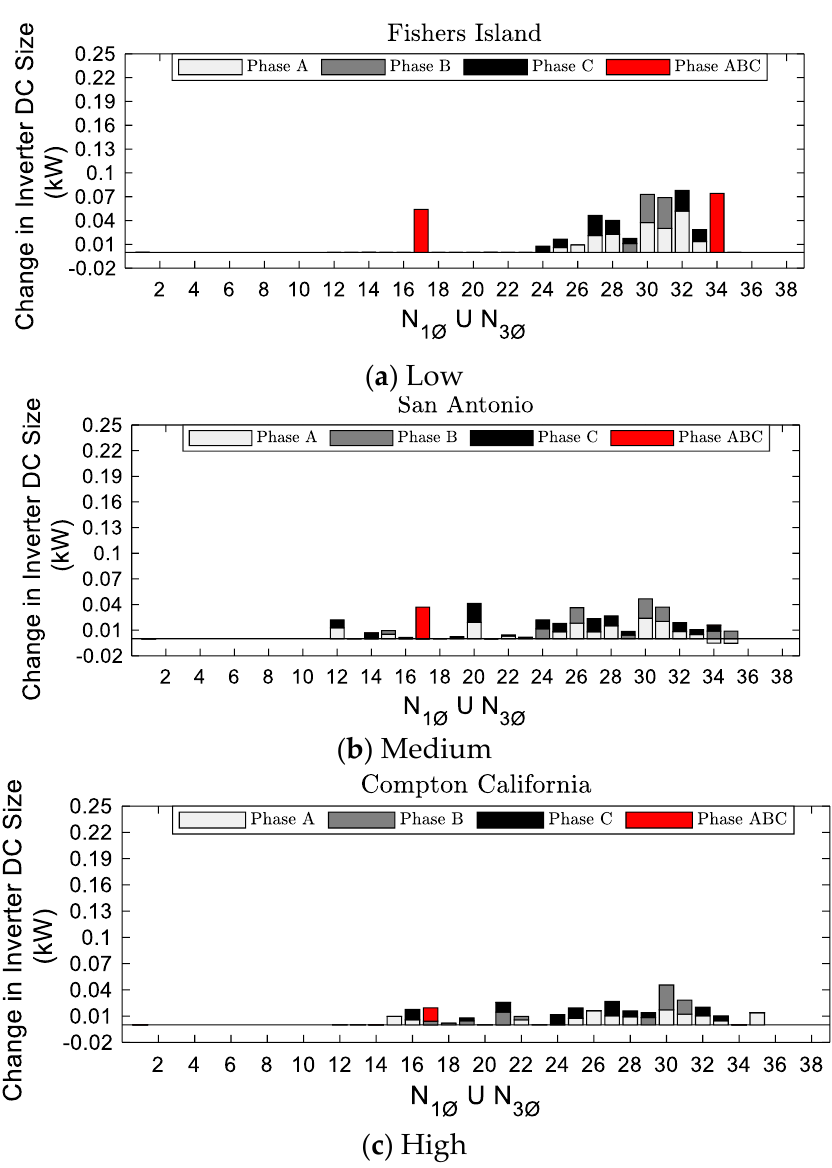
Figure 7. PV inverter placement and size with load change of +10% in region 1 and +40% in region 2.